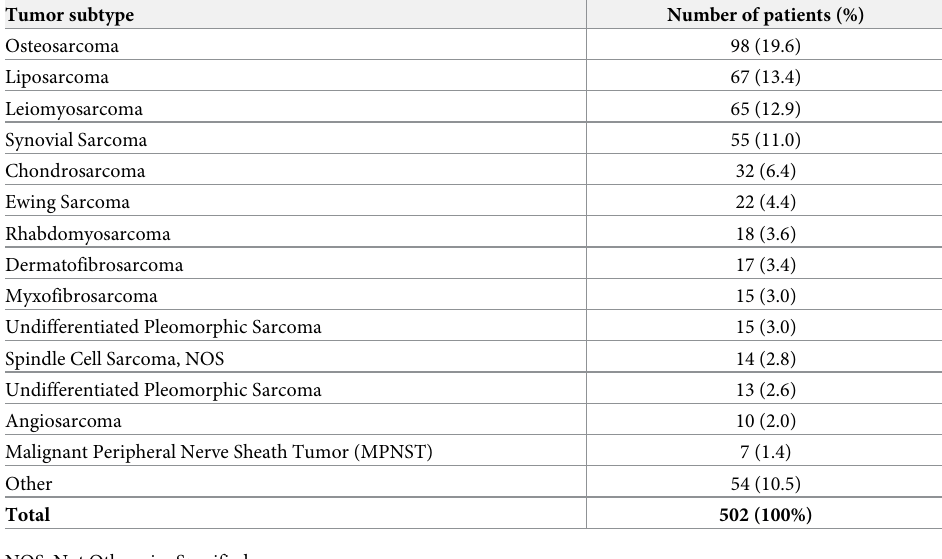
Table 1. Patients’ classification according to histologic